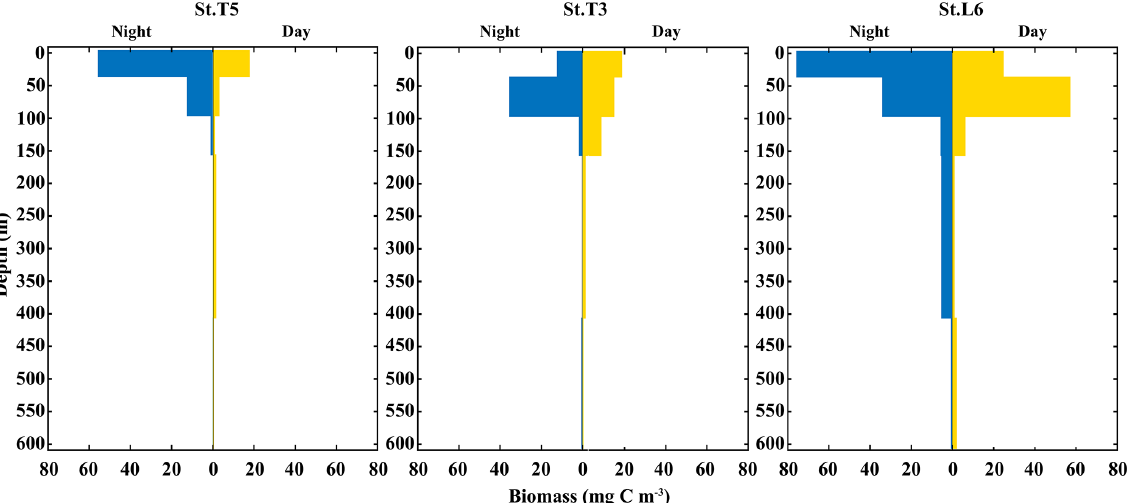
Figure 5. Vertical distribution of total zooplankton biomass during daytime and nighttime conditions at three stations off northern Chile: off Iquique (Stations T5 and T3) and off Coquimbo (Station L6) during 2 consecutive days in the austral spring